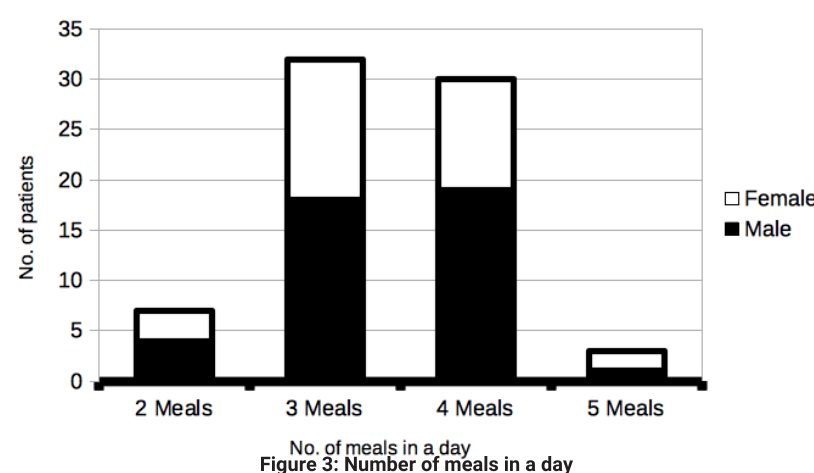
Figure 3: Number of meals in a day